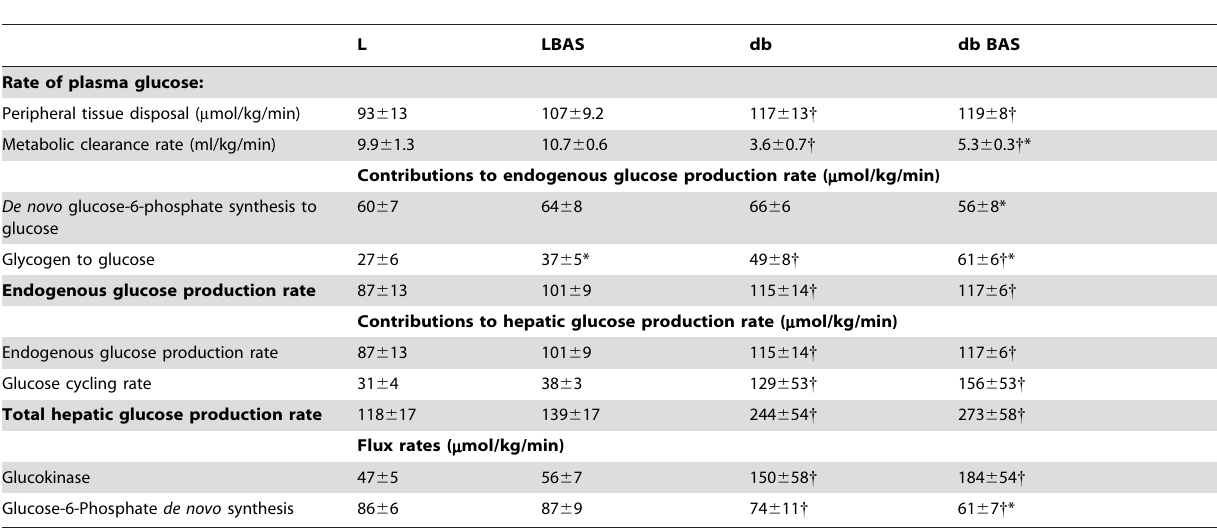
I n vivo parameters of hepatic glucose metabolism during the last 3 hours of the infusion experiment in lean mice (L), lean mice supplemented with BAS (L BAS), db/ db mice (db) and db/db mice supplemented with BAS (db BAS) are depicted in the table, the graphic Graphic S1 illustrates the individual glucose fluxes for a better understanding of the table in a schematic manner. The second panel of the table entitled ‘‘Contributions to endogenous glucose production rate’’ shows the contribution of de novo glucose-6-phosphate synthesis to glucose (displayed as fluxes e + b in Graphic S1) and of glycogen to glucose (displayed as fluxes c + b Graphic S1) which altogether make up the endogenous glucose production rate. The third panel entitled ‘‘Contributions to hepatic glucose production rate’’ takes into account the glucose cycling rate and thus shows the contributions of the endogenous glucose production rate and the glucose cycling rate (which consists of the cycling of glucose: 1. from glucose to glucose-6-phosphate (depicted as a in the graphic, the glucokinase flux) and back (depicted as b in Graphic S1, the glucose-6-phosphatase flux); 2. Glucose-6-phosphate to glycogen and back, fluxes c + d in Graphic S1; and 3. Gluconeogenesis, flux e in the graphic (glycolysis is also a part of this but cannot be measured in the present set up) to the total hepatic glucose production rate which equals the flux rate through glucose-6-phosphatase. The lower panel shows the flux rates through glucokinase (a in the graphic) and the rate of glucose-6-phosphate de novo synthesis (c + e in Graphic S1). Each value represents the mean 6 SD; *p , 0.05 vs. same genotype untreated; { p , 0.05 vs. L same condition.